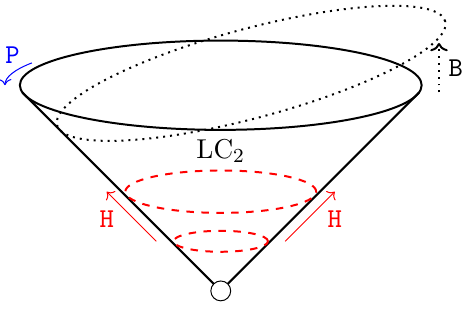
Figure 2 . Two-dimensional future light cone of three-dimensional Minkowski space with vertex removed. Topologically, this is a strip like (A)dS 2